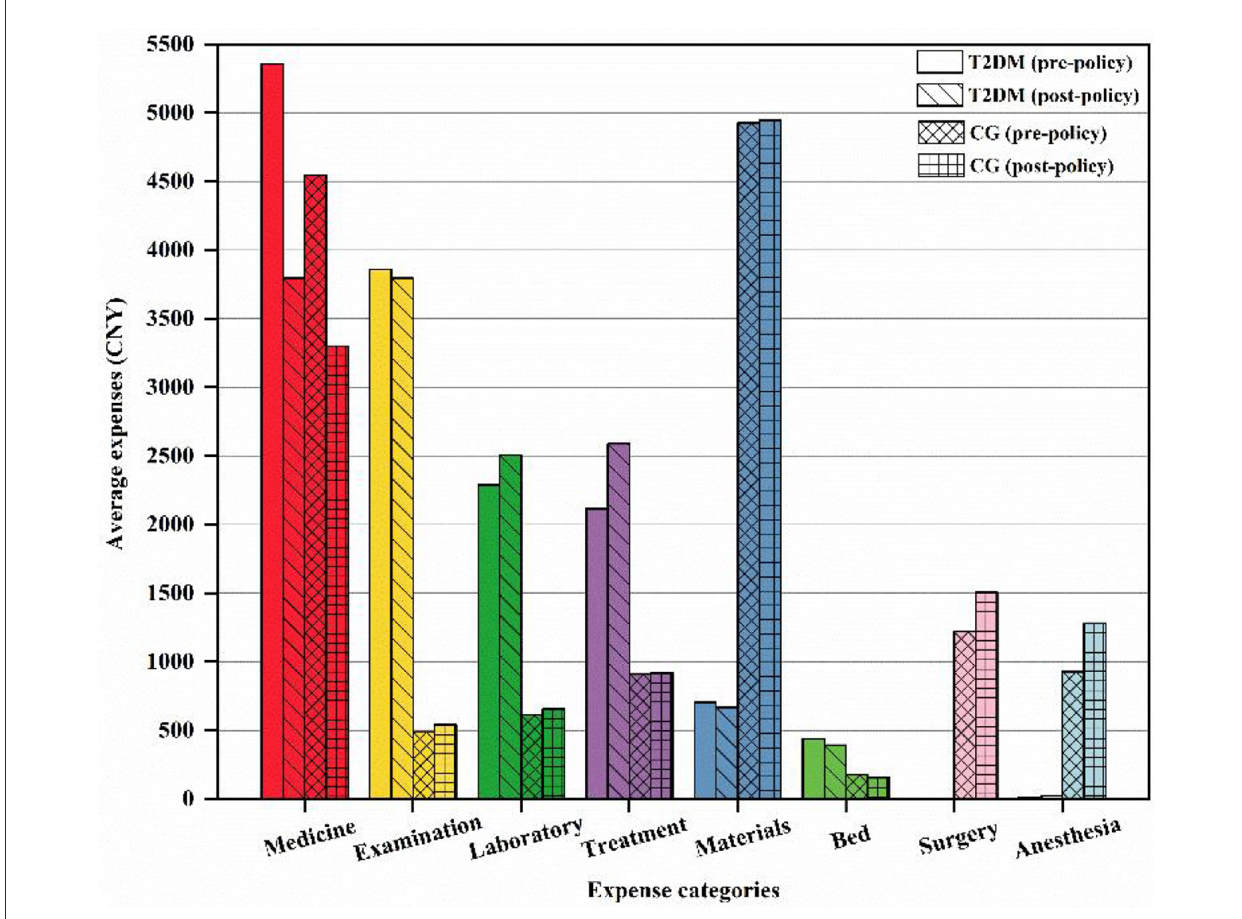
FIGURE2 Comparison of average expenses for two diseases before and after the policy.